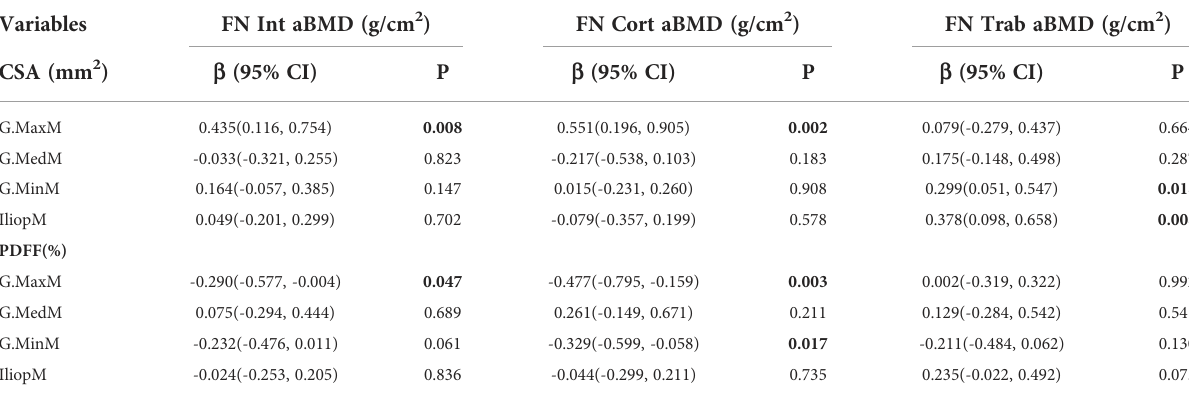
TABLE 3 Generalized multiple linear standardized regression coef fi cients and 95% CIs between the aBMD of the FN and various muscle indexes a, b,c in females.